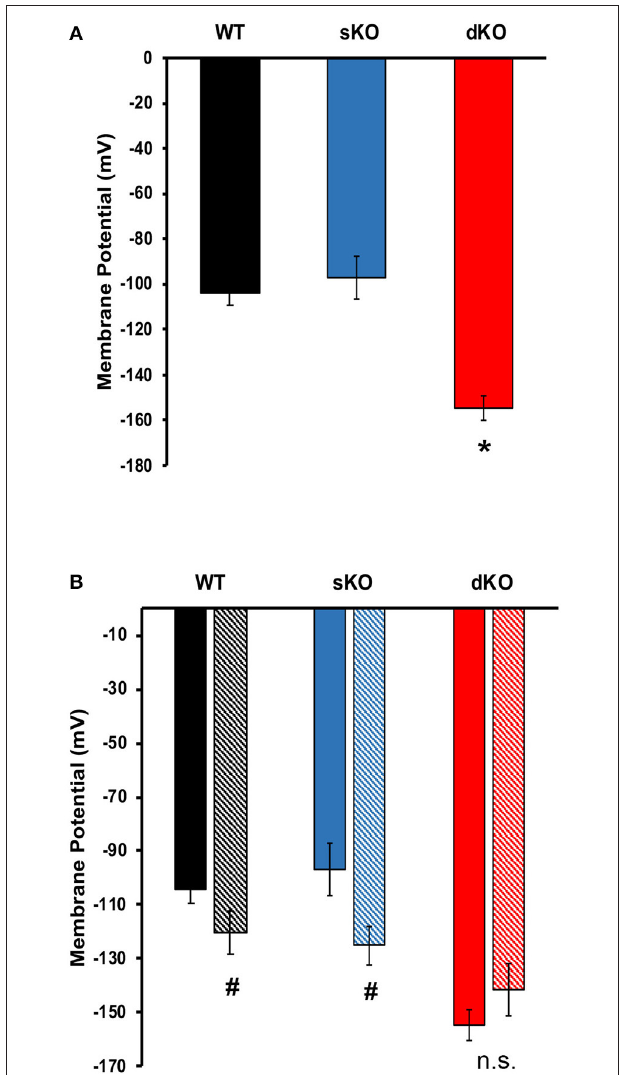
FIGURE 5 | Membrane potential. (A) Resting membrane potential of epimastigotes WT (black), TcCAKC sKO (blue) and TcCAKC dKO (red) in standard buffer with 1 µ M DisBac 2 (3). (B) Resting membrane potential of epimastigotes in standard buffer (solid bars) or NMDG buffer (striped bars). Values represent Mean ± SD of 5 independent experiments. * p < 0.05 compared with WT, # p < 0.05 compared with the values obtained in standard